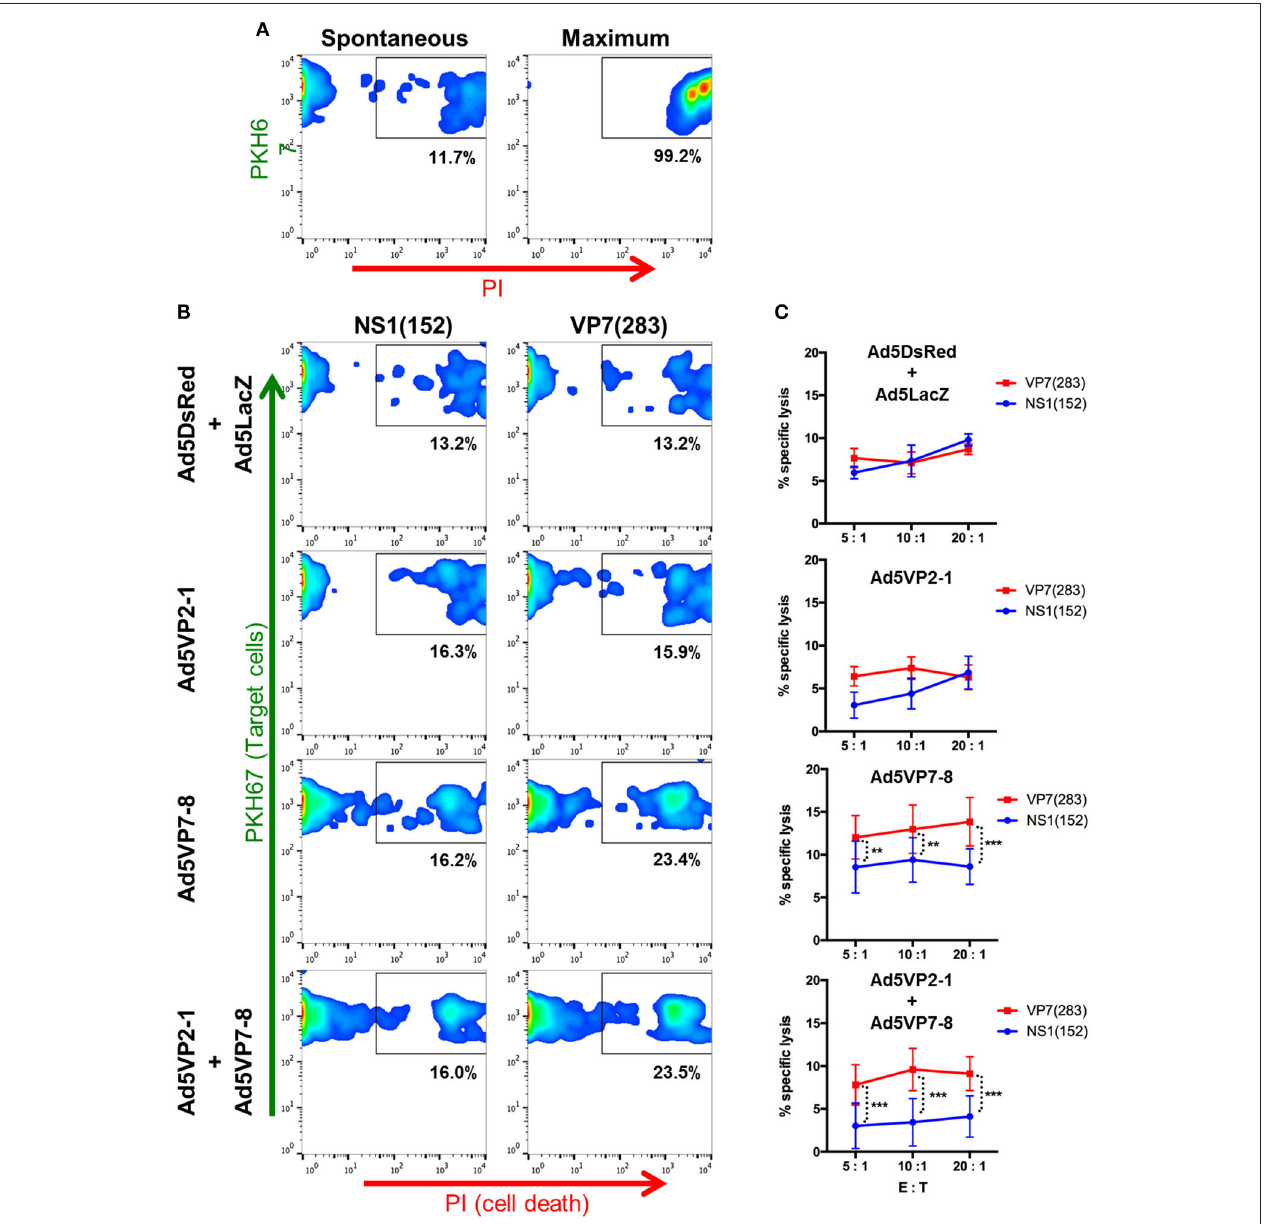
FIGURE 6 | The Ad5VP7-8 immunization induces cytotoxic T lymphocytes (CTL) against the VP7(283) peptide. Splenocytes from immunized mice were restimulated in vitro with the VP7(283) peptide and used as effector cells in flow cytometry-based cytotoxicity assays. RMA/S cells pulsed with VP7(283) peptide or irrelevant peptide NS1(152) were labeled with PKH67 dye and used at target cells. Propidium iodide (PI) staining was used to evaluate cell death. (A) Dot plot examples of spontaneous and maximum target cell death. (B) Dot plot examples of peptide-pulsed RMA/S target cell death in co-cultures with splenocytes obtained from Ad5DsRed + Ad5LacZ, Ad5VP2-1, Ad5VP7-8, or Ad5VP2-1 + Ad5VP7-8 immunized mice. (C) Percentage (mean ± SD) of target cell specific lysis induced by splenocytes from Ad5DsRed + Ad5LacZ ( n = 3 ), Ad5VP2-1 ( n = 4), Ad5VP7-8 ( n = 6), or Ad5VP2-1 + Ad5VP7-8 ( n = 5) immunized mice at different effector to target cell ratios (E:T). ** p < 0.01; *** p < 0.001; two-way ANOVA with Sidak’s post-test [NS1(152) vs.